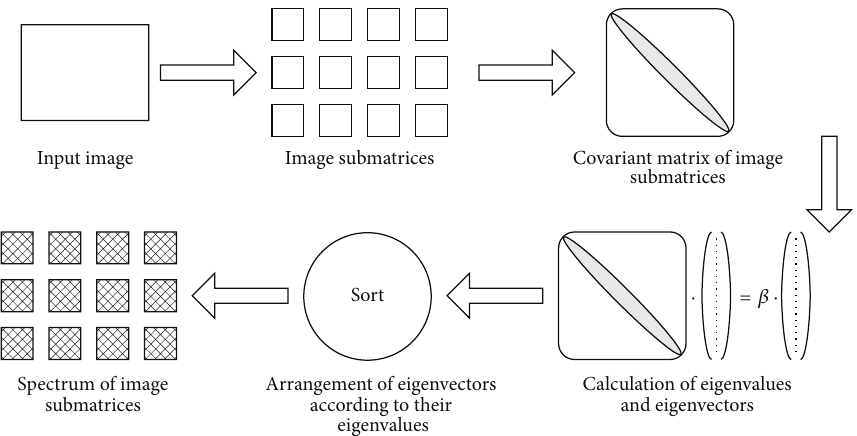
Figure 5: The integral transform part of KLT coder.